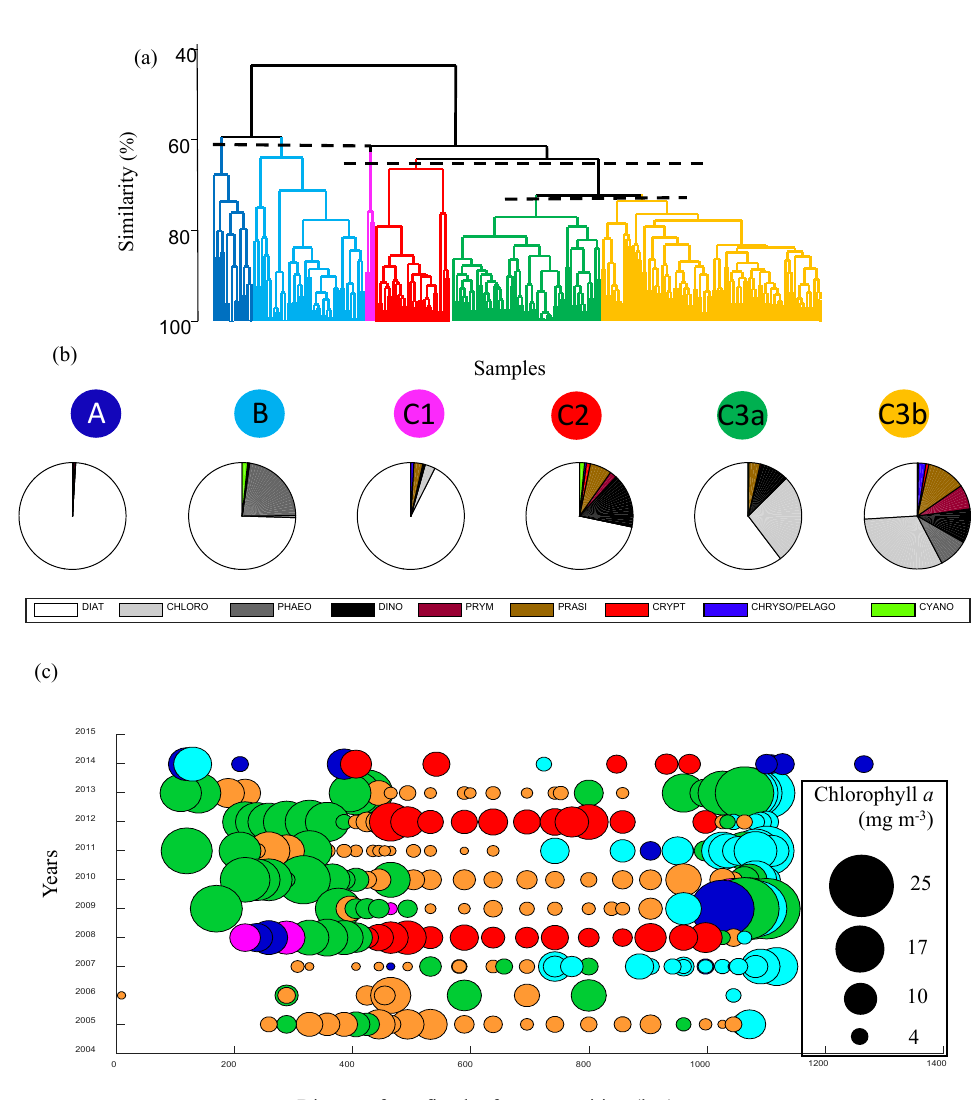
Figure 4. Dendrogram showing clustering of samples (a) and the proportion of chlorophyll a contributed by each phytoplankton group for each cluster (b) . Spatial distribution of distinct phytoplankton communities (cluster groups) along the section, showing the distance from the star in Fig. 2a) (c) . Bubble size in (c) represents total chlorophyll a biomass (minimum 0.3mgChl a f m − 3 and maximum 25mgChl a f m − 3 )